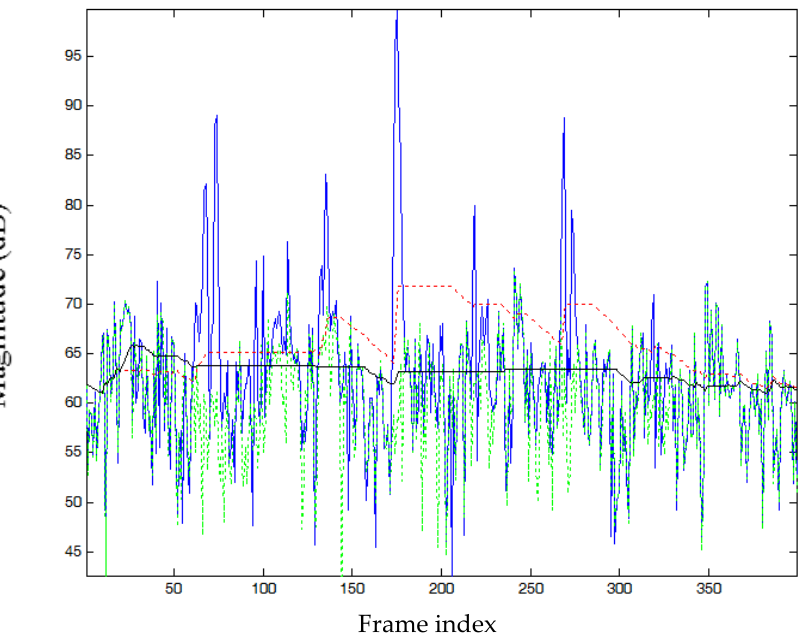
Figure 4. Contour of the estimated noise power for a sub-band of speech (spoken by a female speaker, interfered by factory noise with an average SegSNR = 10 dB). Blue line: Power of noisy speech; green dotted line: true noise; red dotted line: estimated by MCRA method; black solid line: proposed method.